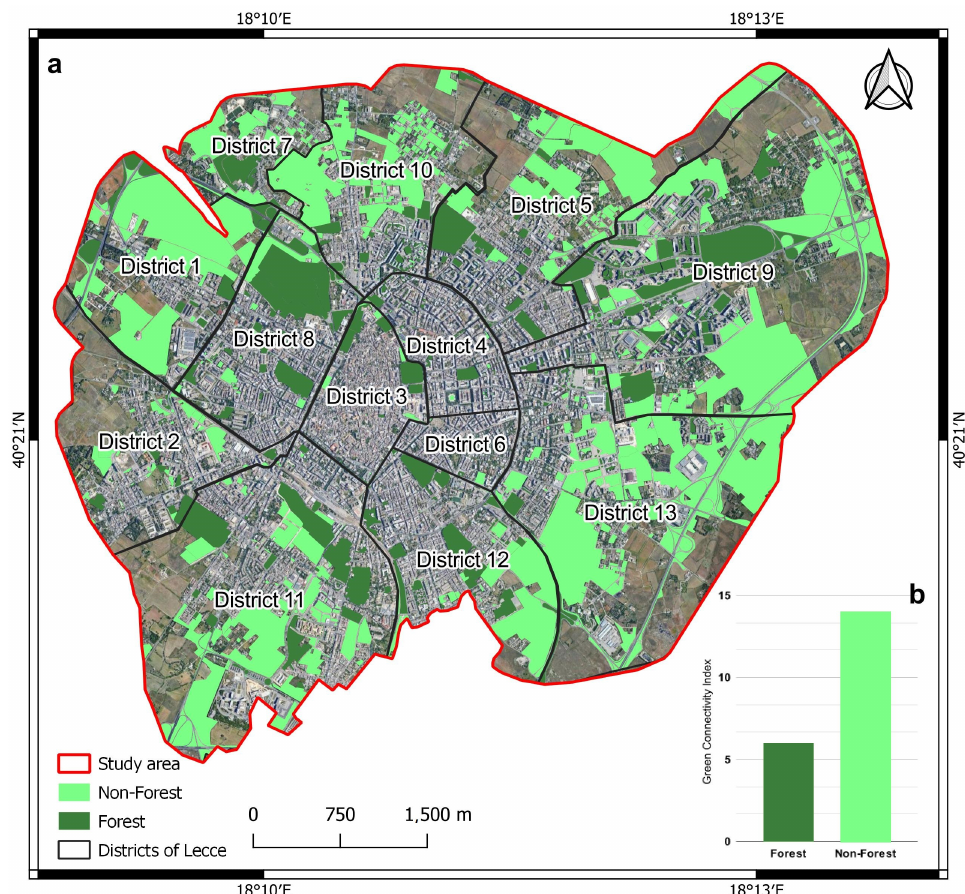
Figure 5. ( a ) Map of Forest and Non-Forest Area; ( b ) Green Connectivity Index for Forest and Non-Forest